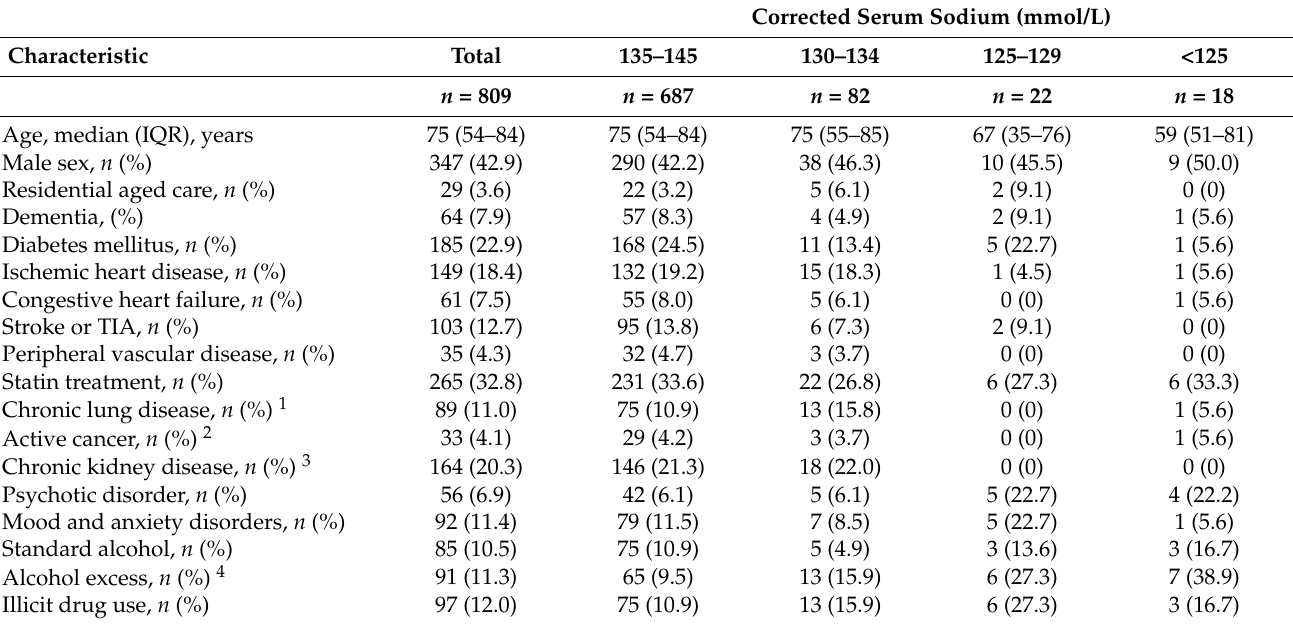
Table 1. Baseline patient characteristics at hospital presentation grouped by serum sodium concentration. Corrected Serum Sodium